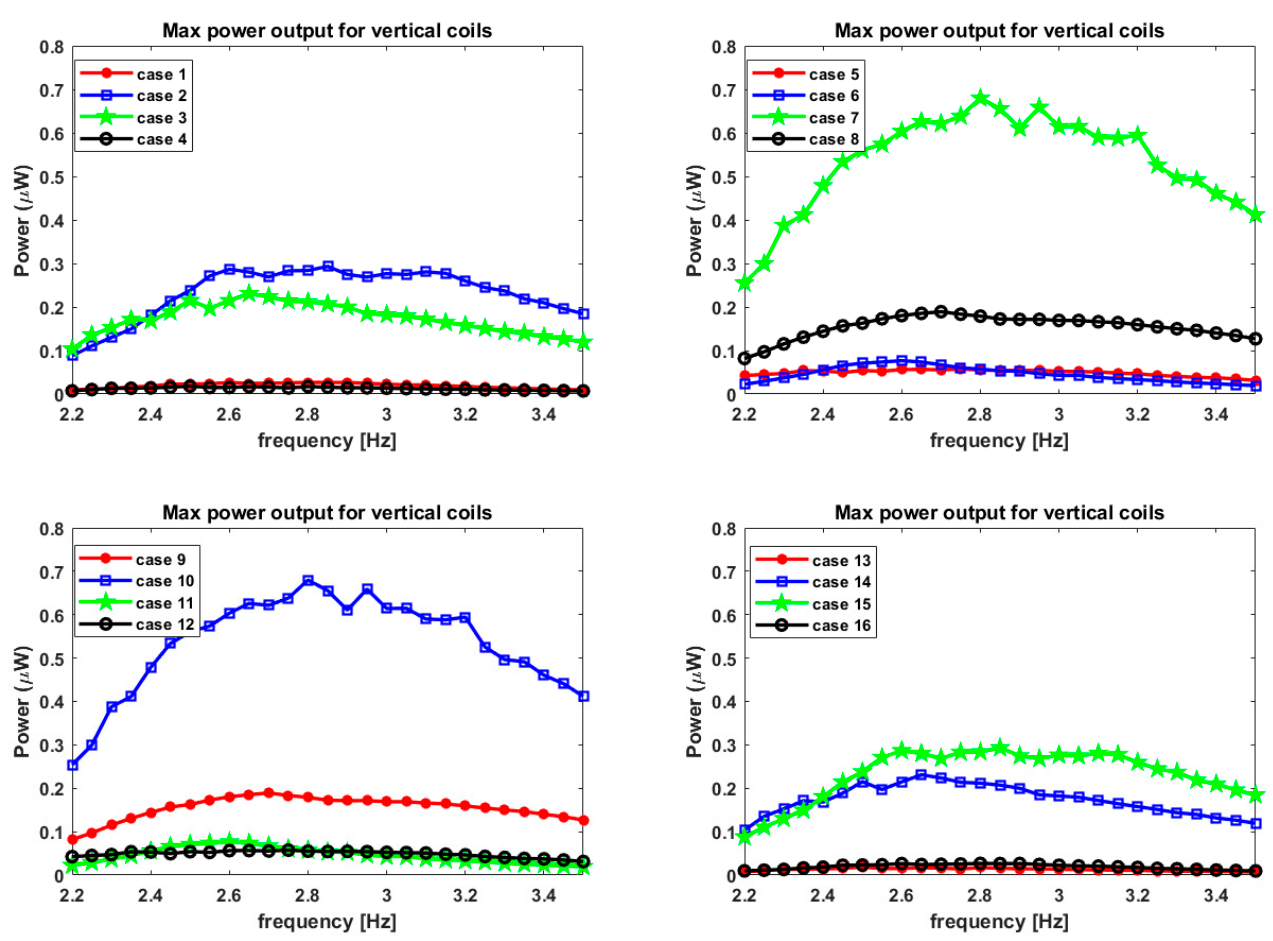
Figure 19. Maximum power output from Vertical winding for L = 5 cm tank.